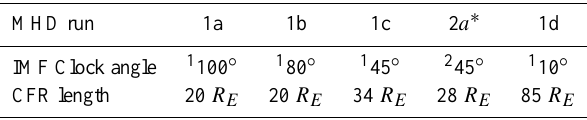
Table 2. The tailward extension of the closed field line region (CFR length) for the constant IMF clock angle